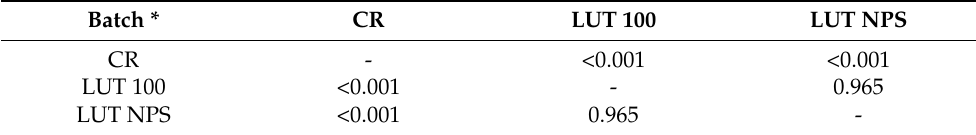
Table 4. Comparison of post hoc TAC results (ng/mg protein) with regard to the batch of the studied